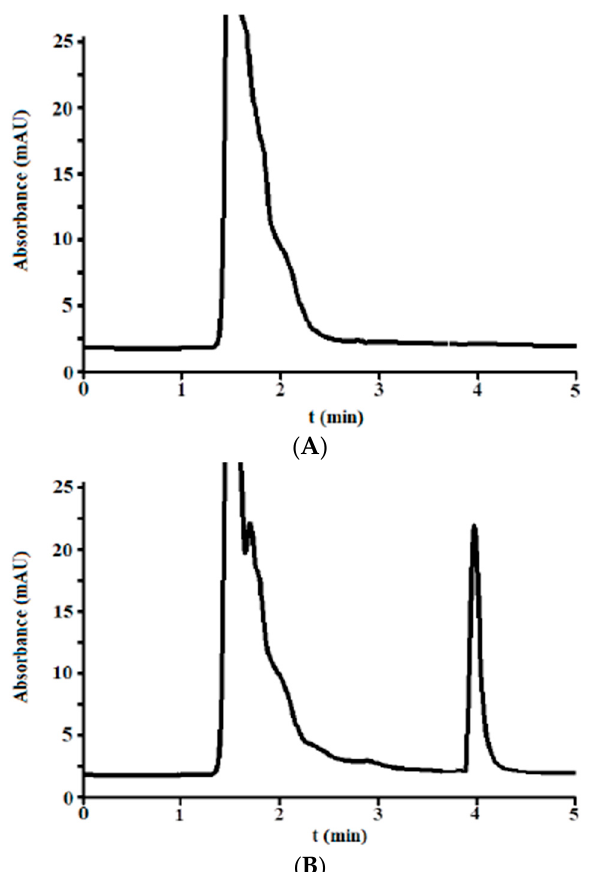
Figure 2. Chromatogram of blank urine from a healthy donor using the optimum chromatographic condition: ( A ) blank and ( B ) fortified at 5 μ g/mL (by adding isoniazid to the blank sample).